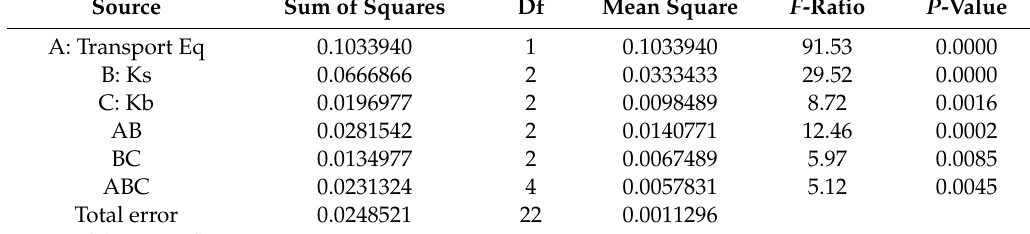
Table 7. ANOVA results for the 3 k experiment.